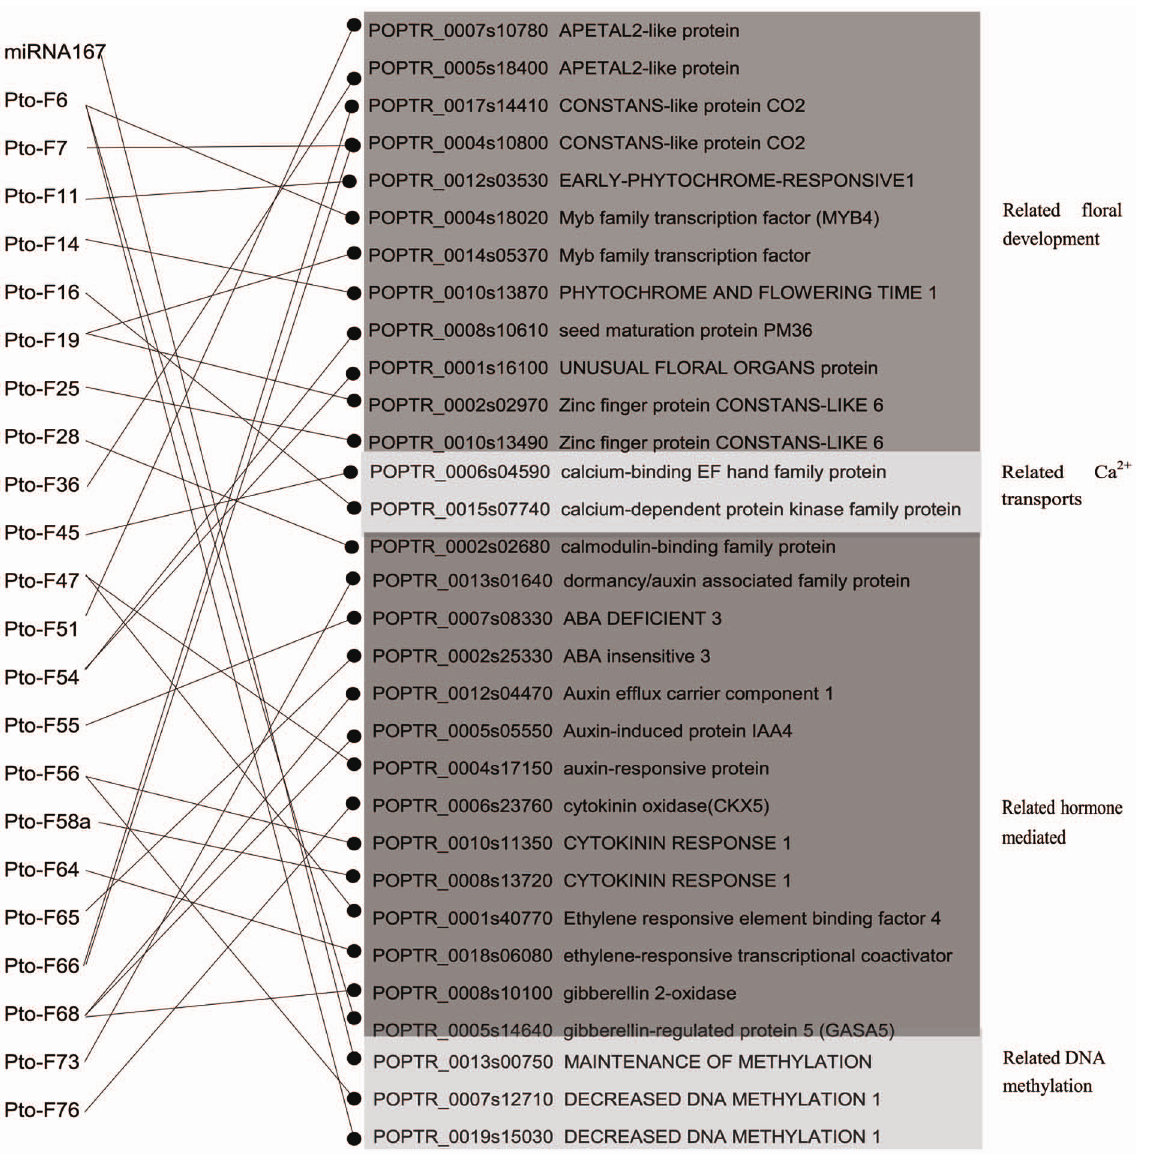
Figure 7. A possible functional network of flower development related miRNAs in andromonoecious P.tomentosa . Black line represent repression of target gene